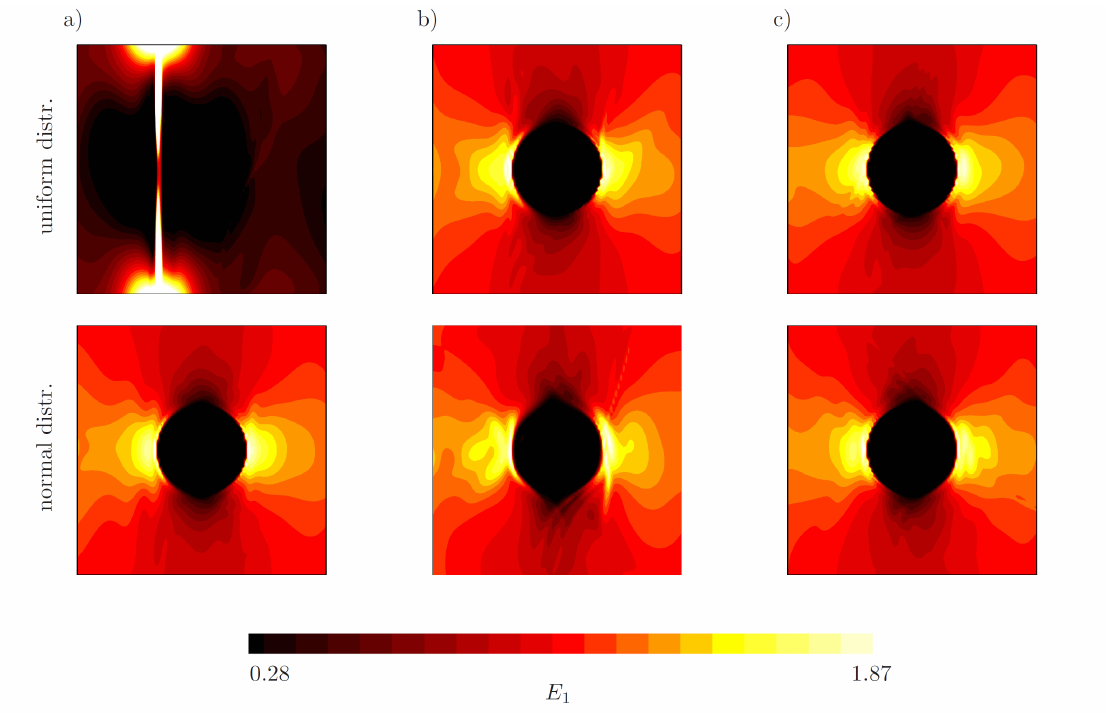
Figure 8. Contour plot of E t 1 for a set of parameters: ( a ) 51 × 51 elements, 15 neurons per layer in N 1 and 5 neurons each for N x and N x ; ( b ) 51 × 51 elements, 10 neurons per layer in N 1 and 5 neurons 2 1 each for N x and N x ; and ( c ) 101 × 101 elements, 15 neurons per layer in N 1 and 5 neurons each for 2 1 N x and N x 2 1